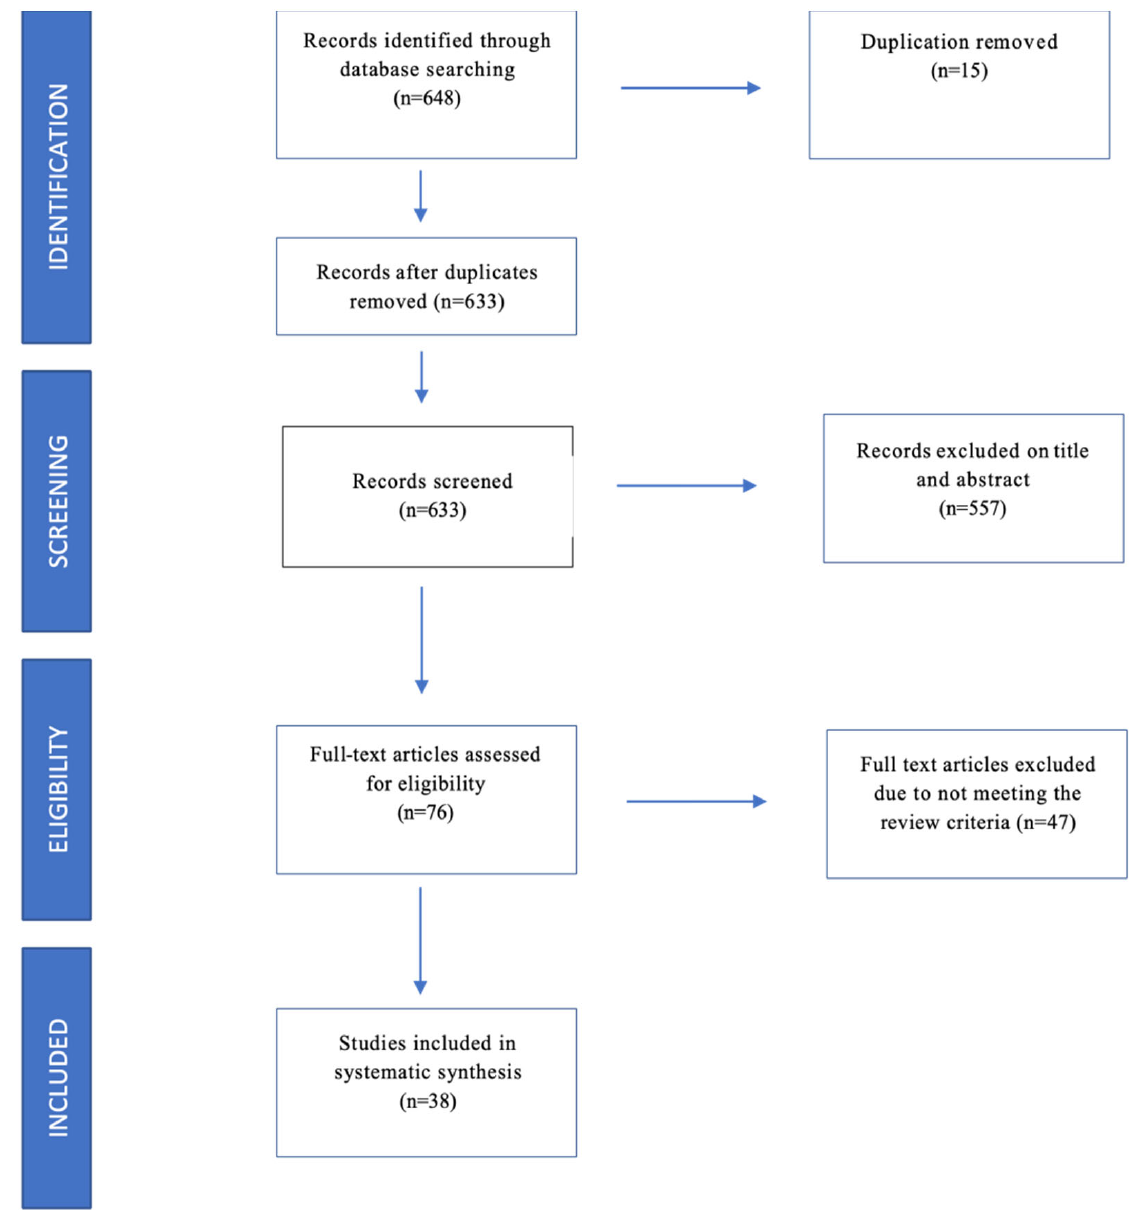
Figure 1. PRISMA fl owchart [17]. Figure 1. PRISMA flowchart